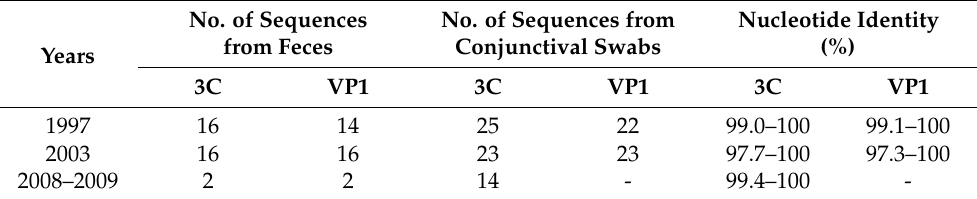
Table 1. Nucleotide identity comparison of 3C and VP1 sequences between stool isolates and those obtained from